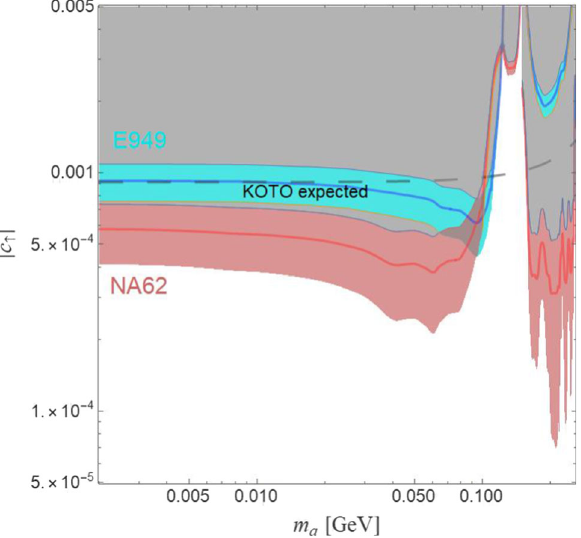
Fig. 5 ExcludedparameterregionsforanuniversalALP-upquarkcou- pling c ↑ derived from NA62 (pink), E949 (cyan) and KOTO expected (dashed line)